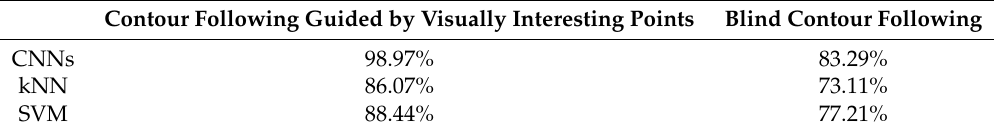
Table 1. Classification accuracy of test data.